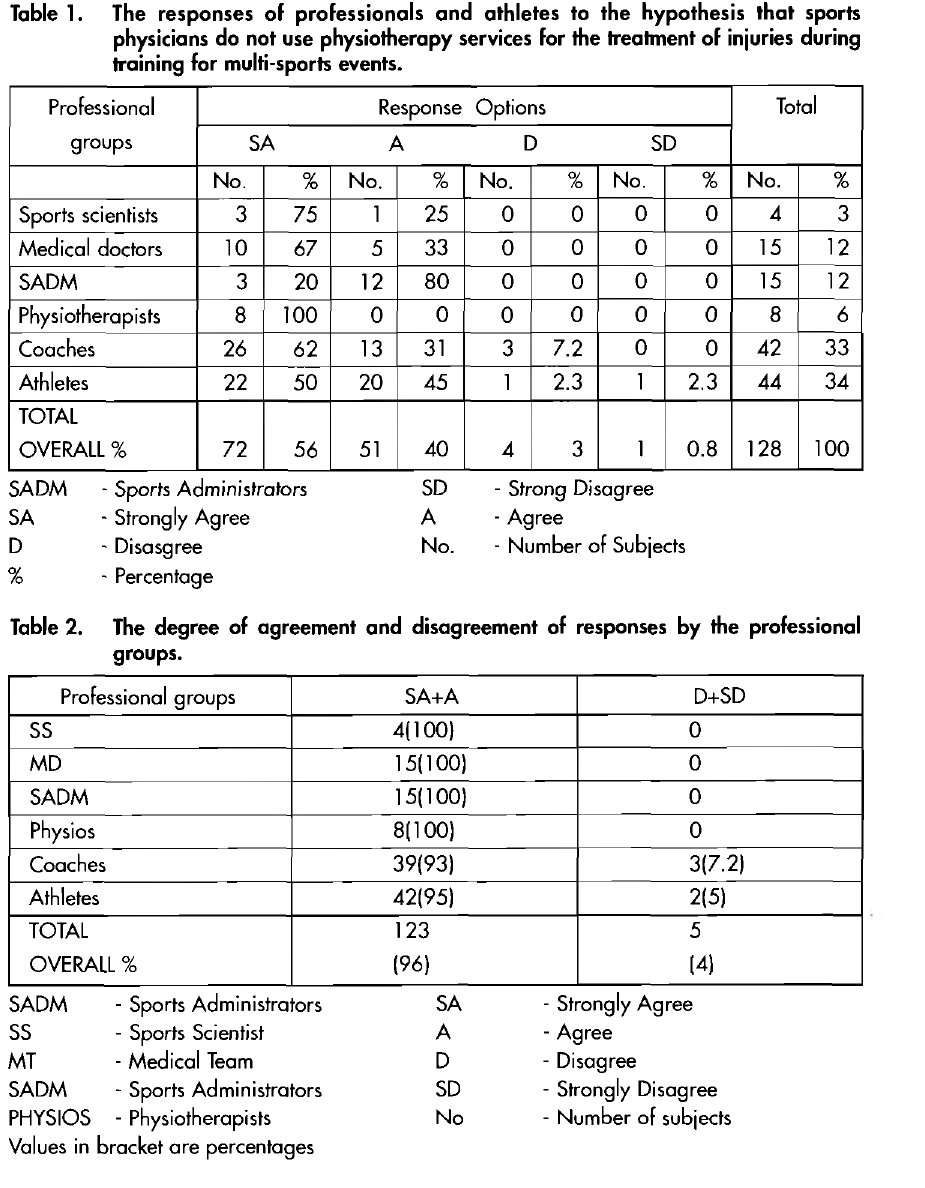
The responses of professionals and athletes to the hypothesis that sports physicians do not use physiotherapy services for the treatment of injuries during training for multi-sports events.